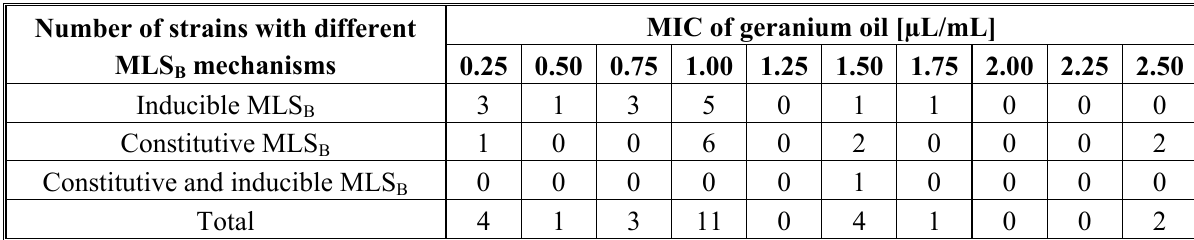
Table 10. MLS resistance in correlation with MICs of geranium oil among S. aureus strains. B Number of strains with different MLS B